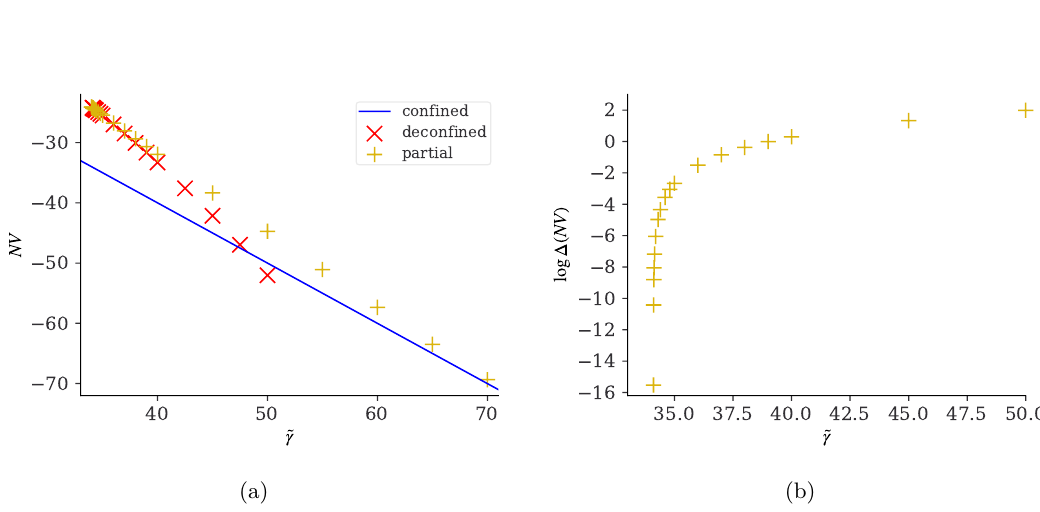
Figure 6. (a) θ = 0 numerical results for N times the free energy V as a function of ˜ γ for N = 30 , showing the confined phase (blue line), deconfined phase (red crosses), and partial phase (gold plus signs). We clearly observe a first-order transition, with the partial phase as the unstable branch connecting the confined and deconfined phases. (b) θ = 0 numerical results for log(∆ NV ) versus ˜ γ for N = 30 , where ∆ NV is the difference in NV between the partial and deconfined phases, ∆ NV ≡ N ( V | − V | ) . Clearly the partial phase has higher free energy than the partial deconf deconfined phase near the transition between them (which at N = ∞ is the GWW